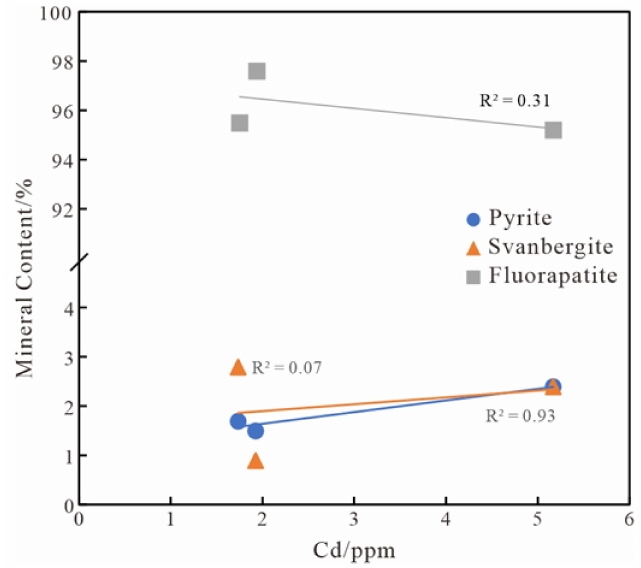
Figure 7. Characteristics of minerals and Cd in phosphate